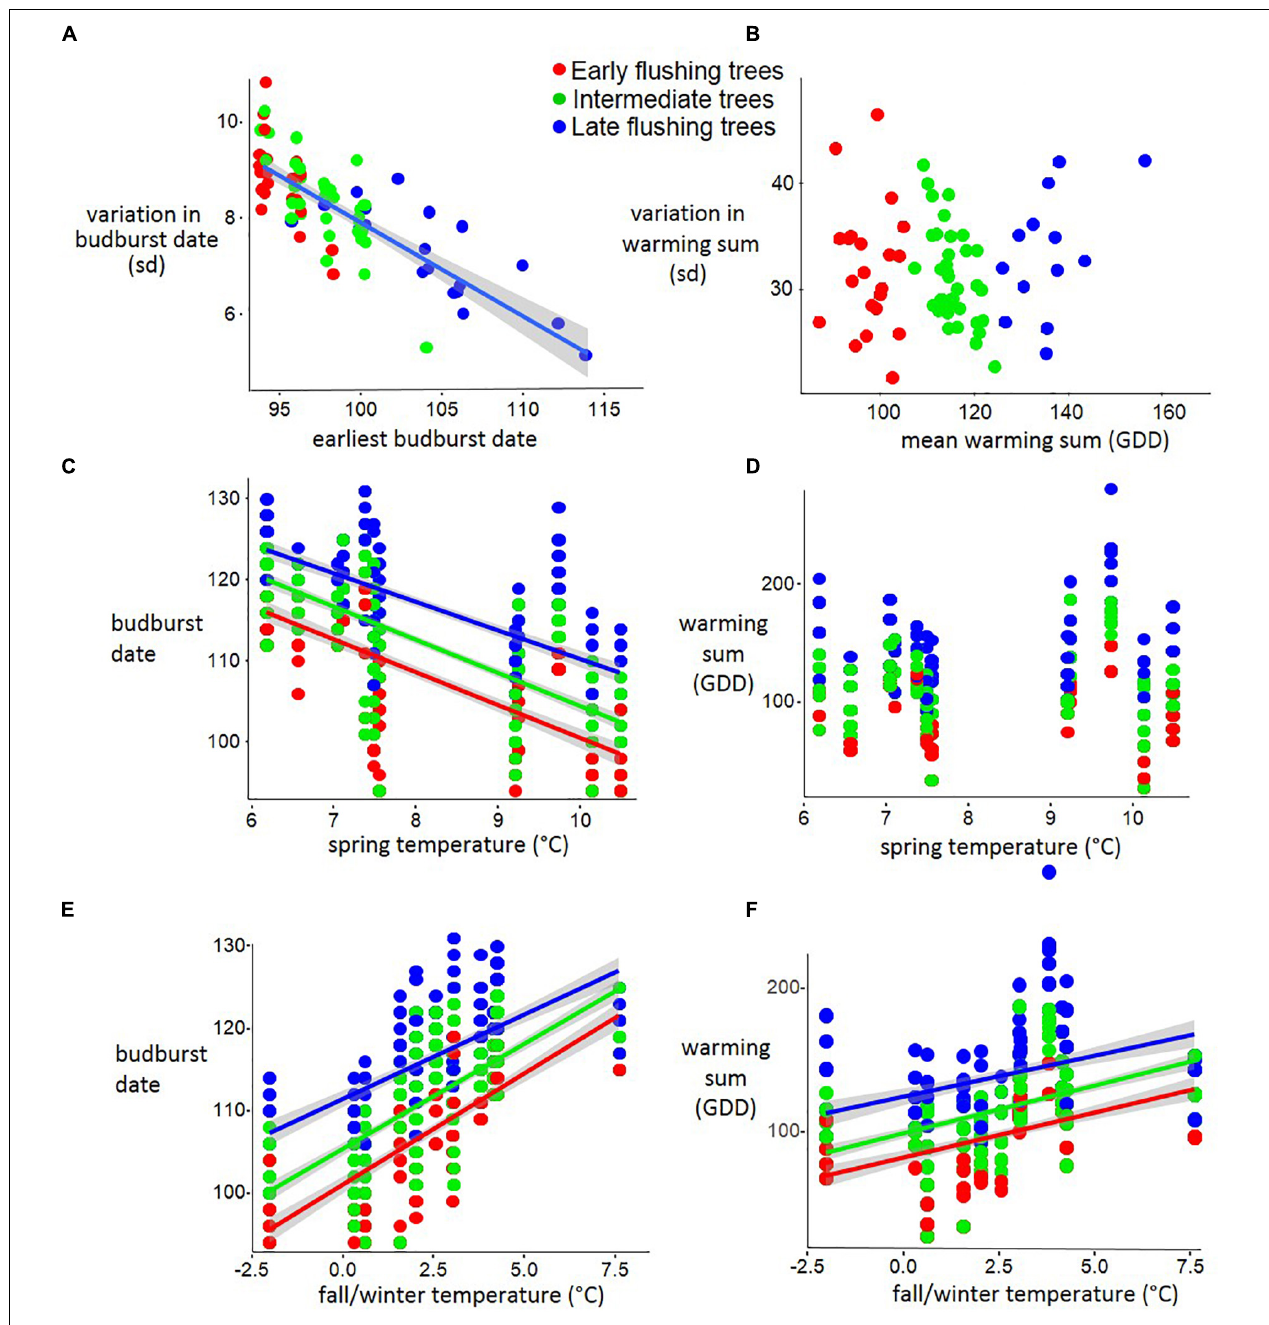
FIGURE 3 | Earlier flushing beech trees have more variable budburst dates but are not more sensitive to temperature in a forest stand (Serrahn data). (A) The budburst date of each tree regressed against its variation across 12 years. (B) The mean warming sum (GDD from January 1) of each tree regressed against